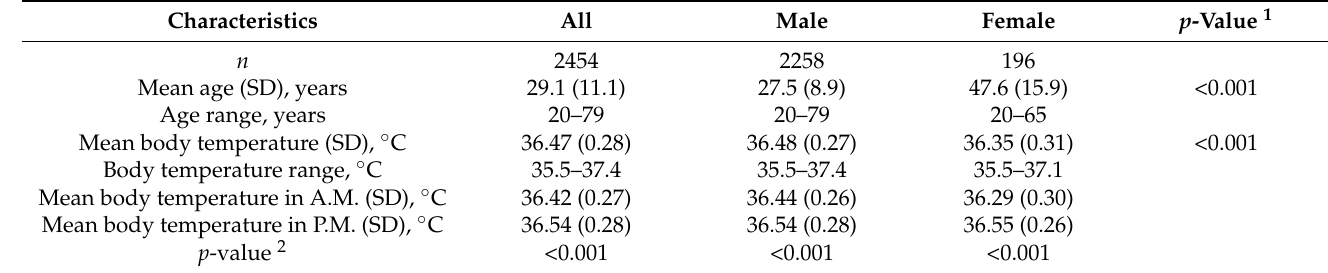
Table 1. Characteristics of the body temperature measurement.